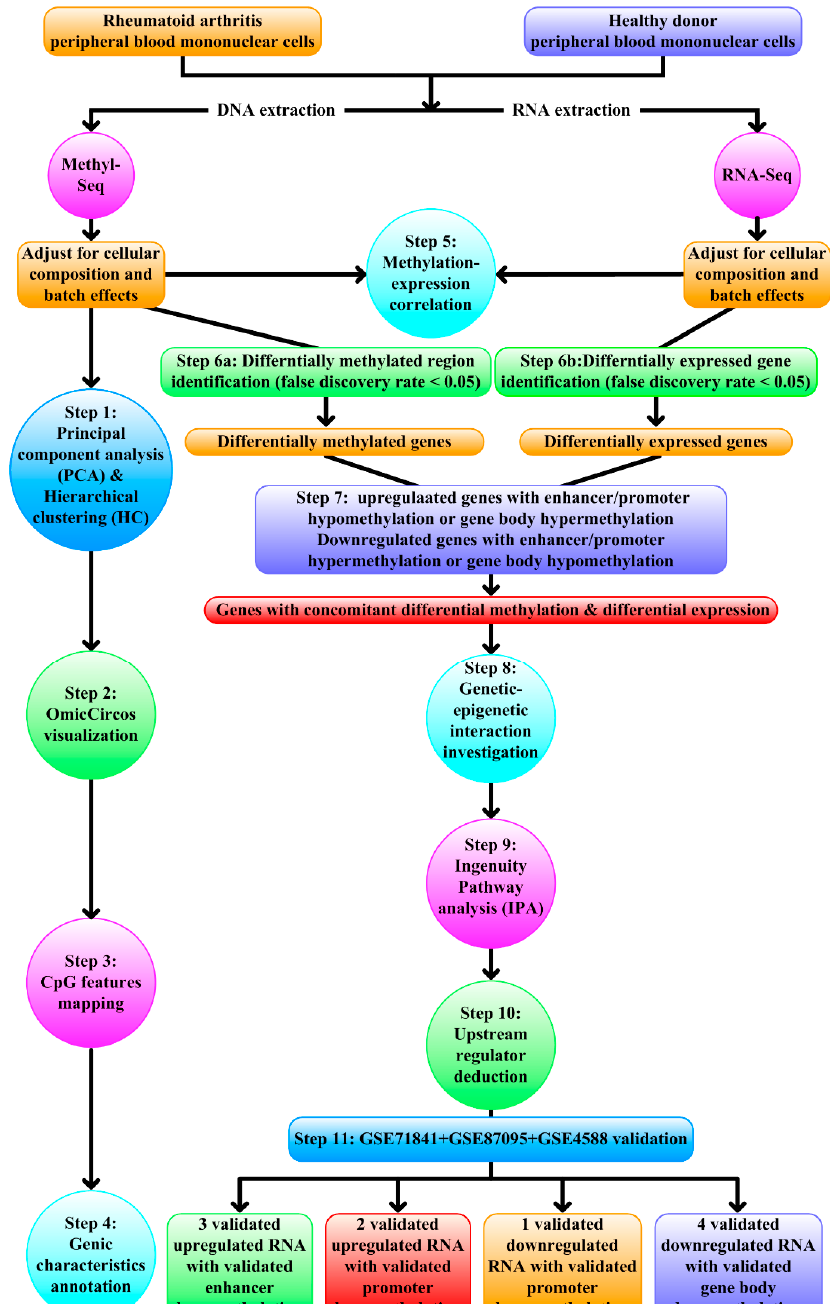
Figure 1. Schematic representation of the next-generation sequencing data analytical workflow. After adjusting for cellular composition and batch effects, methyl-seq data first underwent Principal component analysis (PCA) and hierarchical clustering (HC) (Step 1), OmicCircos visualization (Step 2), CpG features mapping (Step 3), and genic characteristics annotation (Step 4). Methylation and expression profiles were then integrated for methylation-expression correlation (Step 5). Differentially methylated genes (FDR < 0.05) and differentially expressed genes (FDR < 0.05) were identified (Step 6a–6b) and intersected to yield genes with concomitant expression and methylation changes in enhancer/promoter/gene body (Step 7). These differentially methylated and differentially expressed genes underwent genetic–epigenetic interaction investigation (Step 8), IPA (Step 9), and upstream regulator deduction (Step 10). GEO dataset validation (Step 11) confirmed concomitant differential methylation and expression of 10 genes.